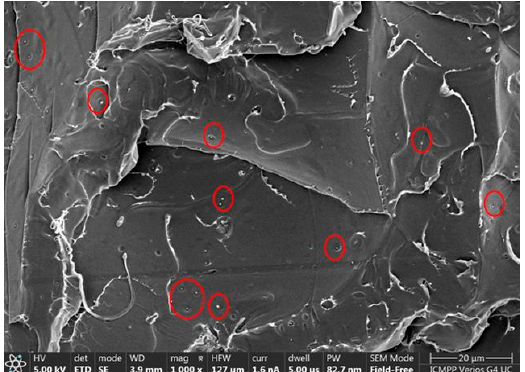
Figure 4. SEM image of the PLA/S material with visualization of sage particle dimensions of ~0.2 μ m (red circles).